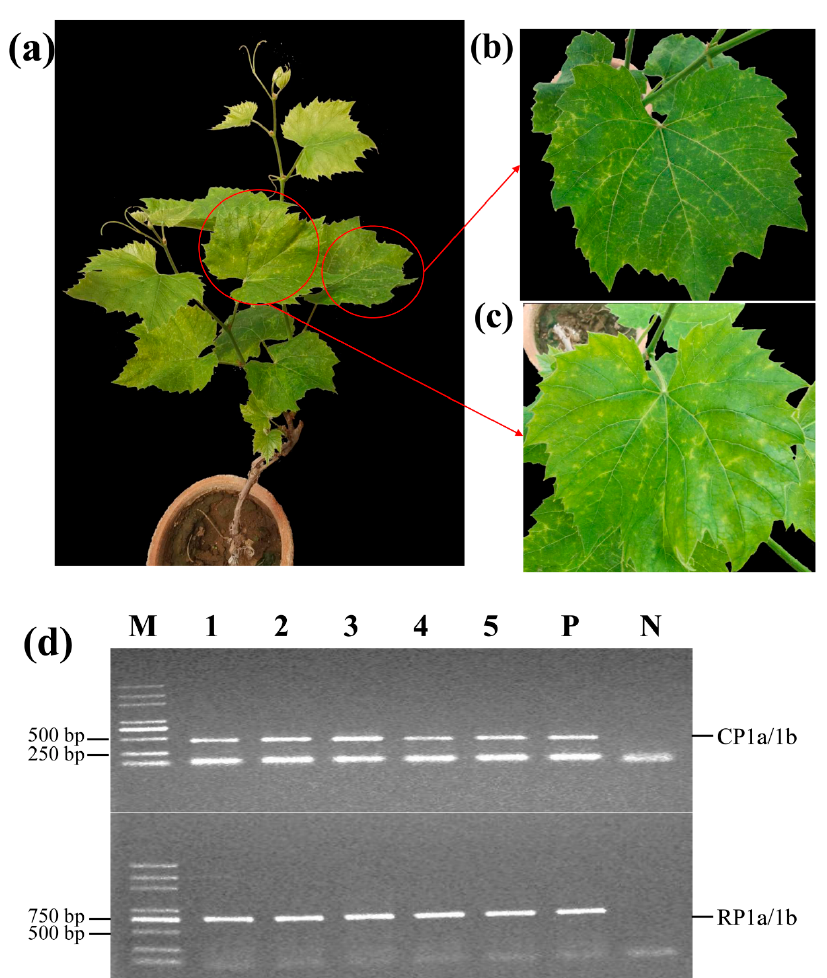
Figure 3. Testing the transmission of grapevine-associated marafivirus (GaMV) to grapevines. ( a ) a grafted ‘Beta’ grapevine; ( b ) and ( c ) partially enlarged images of ( a ); ( d ) Reverse transcription PCR (RT-PCR) detection of GaMV in five grafted grapevines using two sets of specific primers. Lane 1–5, grafted grapevine samples; P, positive control; N, negative control; M, DNA marker DL5000 (TaKaRa).